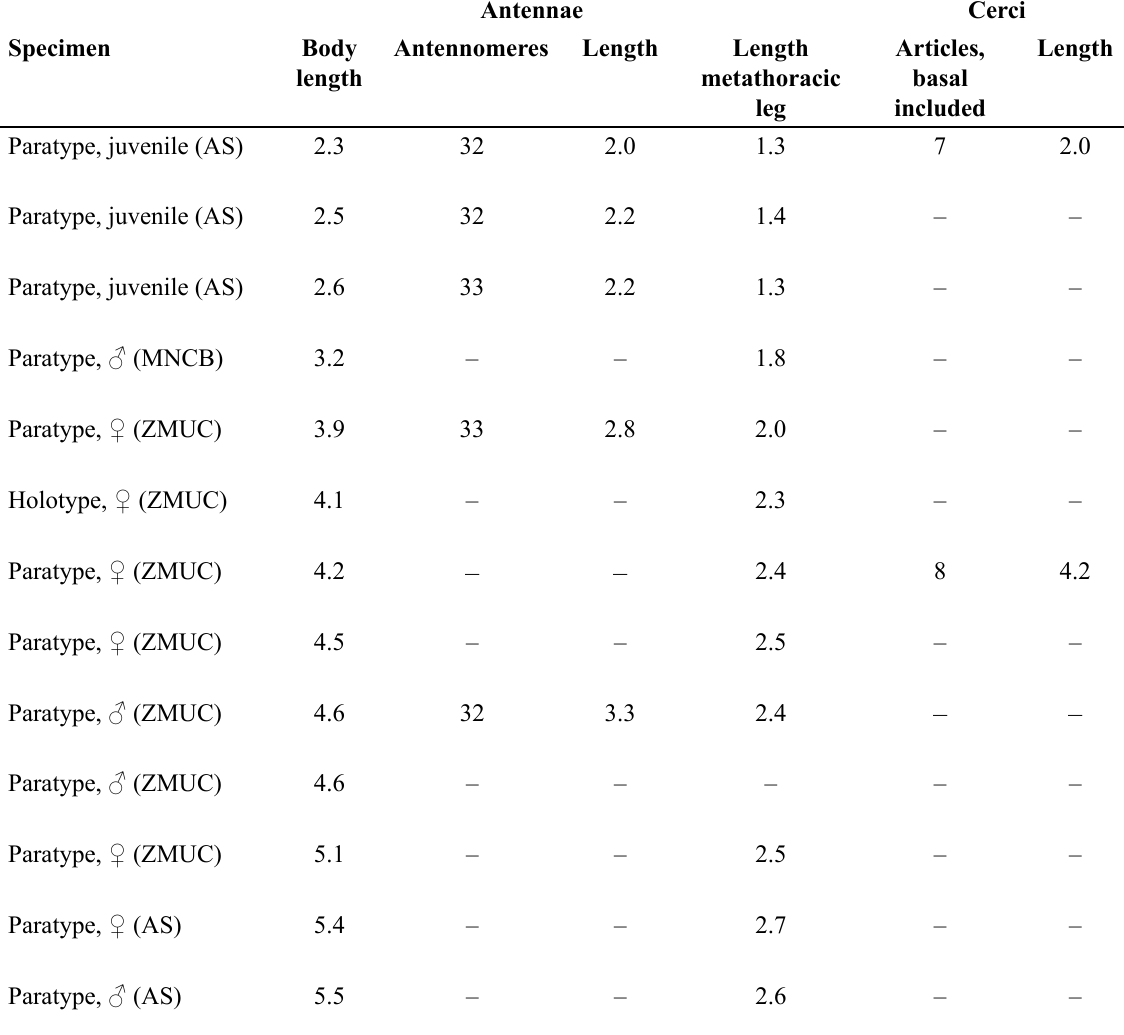
Table 1. Plusiocampa (Pentachaetocampa) inopinata subgen. et sp. nov., length of the body, antennomeres, metathoracic leg and cerci (units in mm), and number of antennomeres and cercal